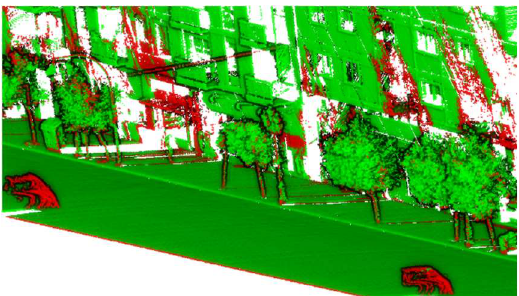
Figure 6: Point cloud coloured by correct semantic Figure 7: Point cloud coloured by correct semantic segmentation for 3 classes, 200 hidden layers and weighted. segmentation for 3 classes, 200 hidden layers and unweighted. Correct segmented classified point in green and misclassified in Correct segmented classified point in green and misclassified in red.